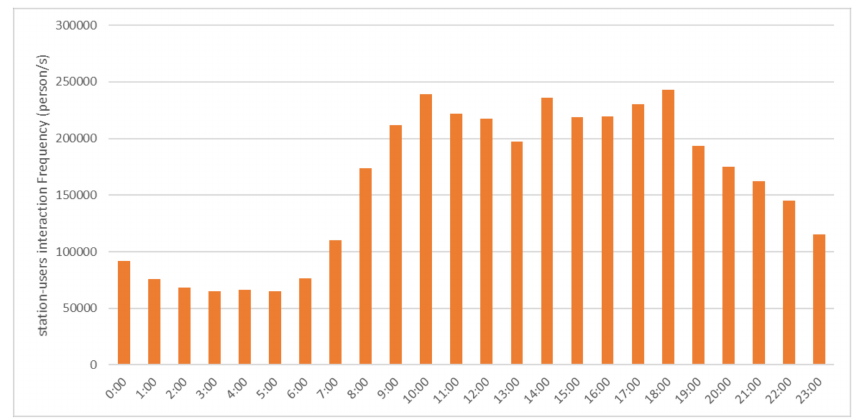
Figure 14. The relationship between base-station–user interaction frequency and time over a